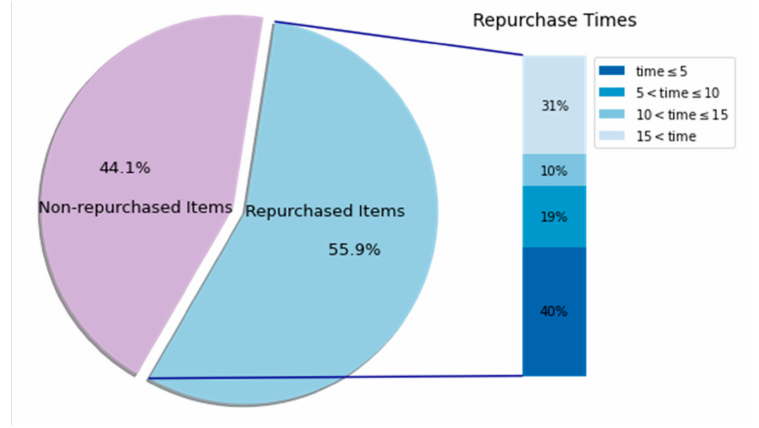
Figure 4. Proportions of repurchased items.